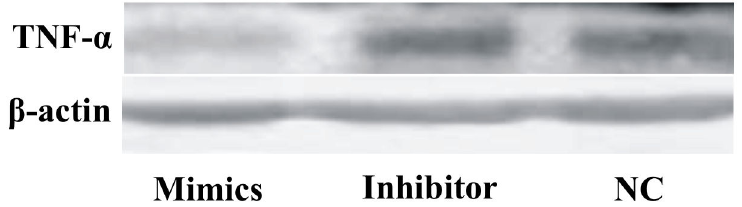
Figure 2. MiR-181aa suppresses TNF-α protein level in Hela cells detected by Western blot.